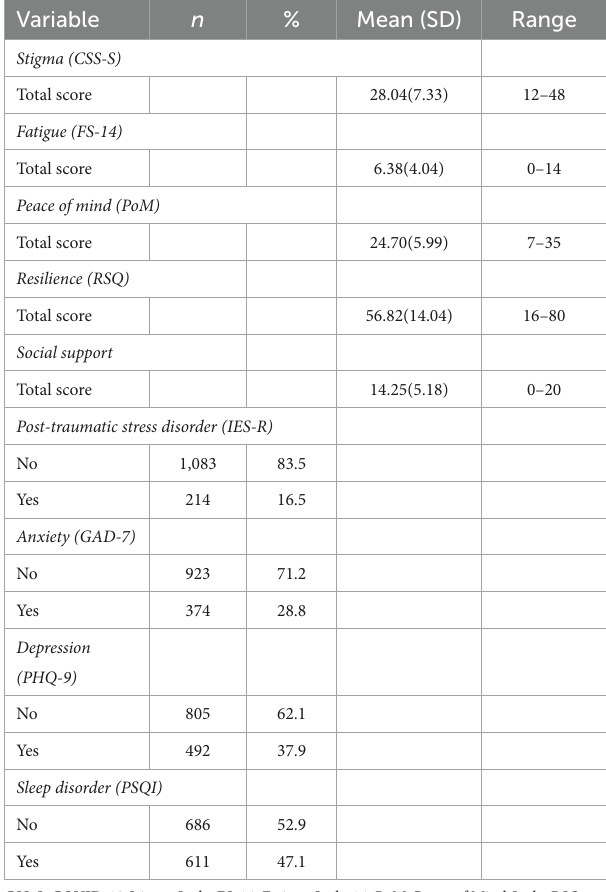
as “non-cases” (i.e., no stigma), and those assigned in “moderate perceived COVID-19 stigma” and “severe perceived COVID-19 stigma” groups were defined as “cases” (i.e., probable stigma). The ROC curve was then plotted for the total score of CSS-S using the binary outcome, with an AUC value of 99.96% ( p < 0.001), indicating a good predictive capacity for perceived COVID-19 stigma (see Figure 3). The diagnostic criteria and indices are illustrated in Table 8. The optimal cut-off value was ≥ 20, where the sensitivity, specificity, and Youden’s index value were 0.996, 0.982, and 0.978, respectively.